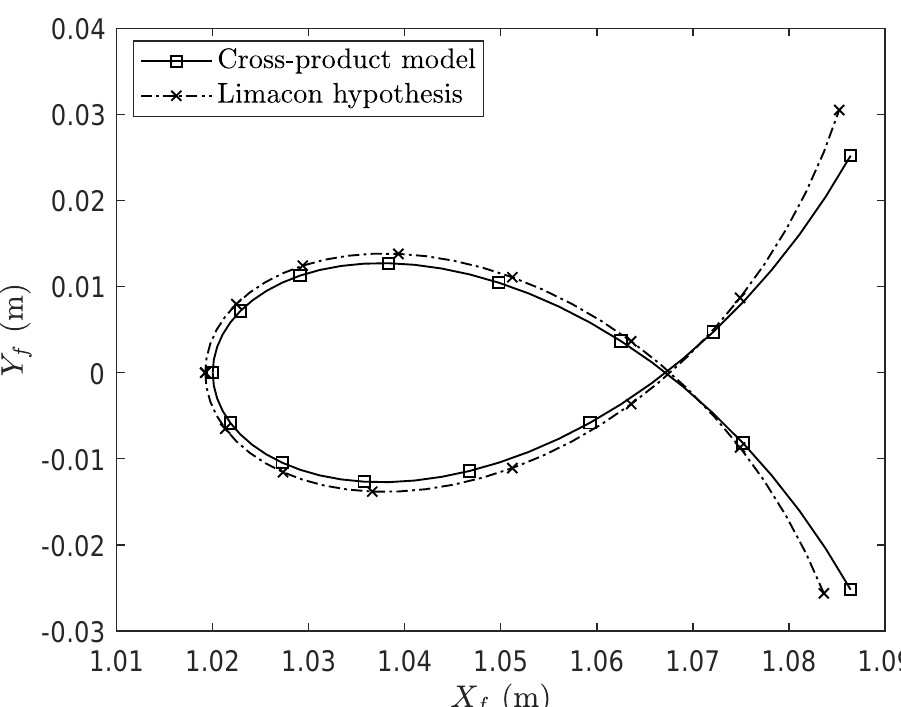
Figure 11. Approximation of the trajectory of the front wheel contact point with a looped Limacon geometrical